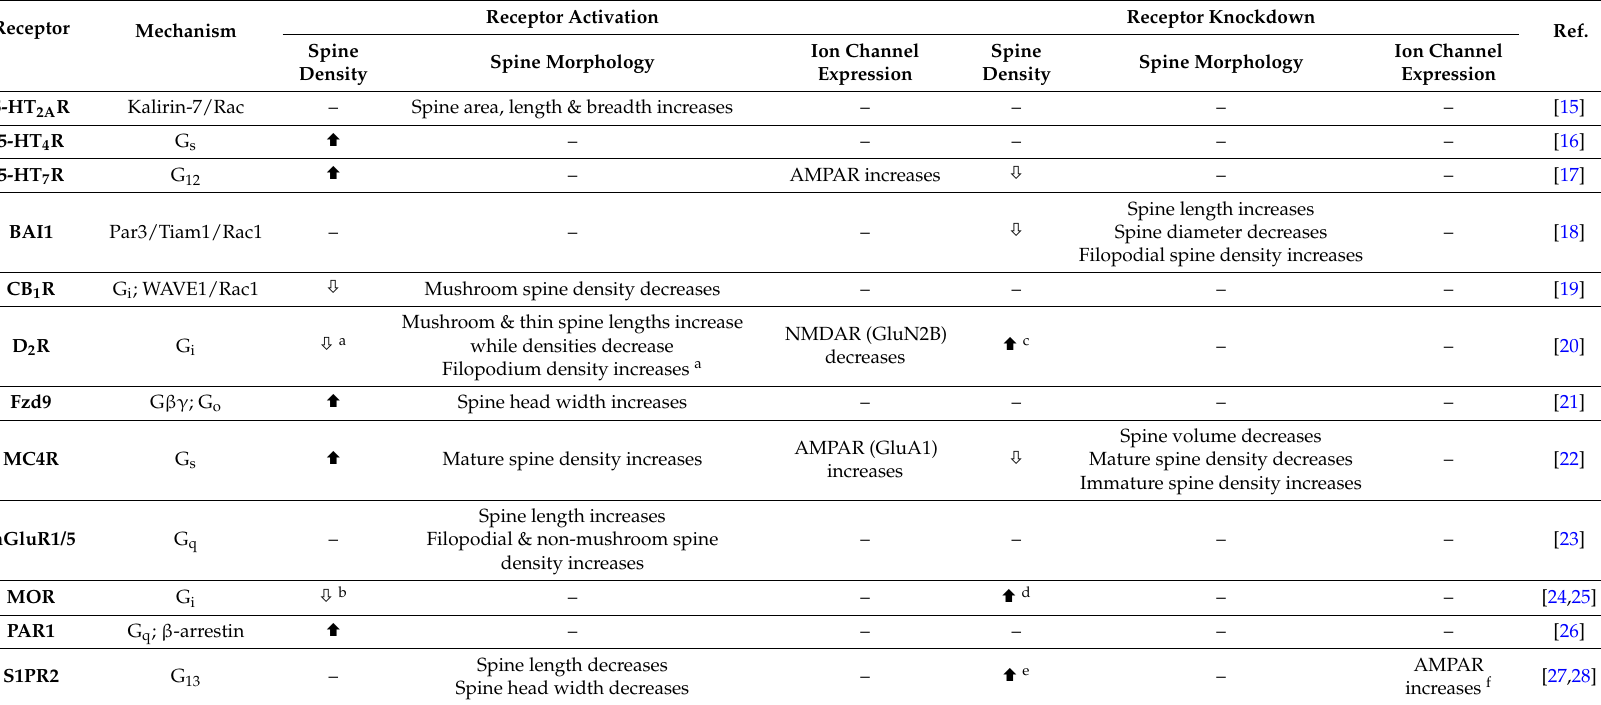
Table 1. Selected G protein-coupled receptors (GPCRs) regulating structural plasticity in the hippocampus and cerebral cortex.